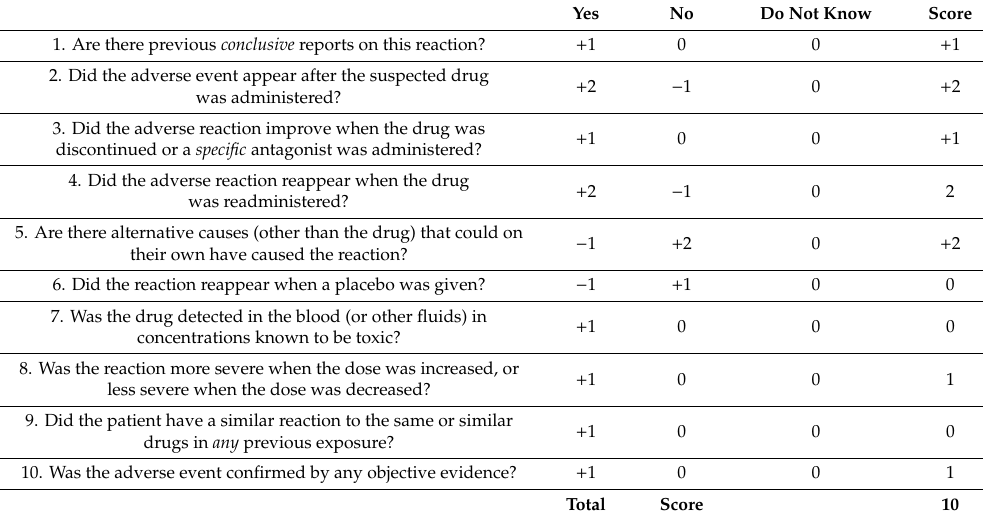
Table 4. The Naranjo scale questions and weighted scores in our